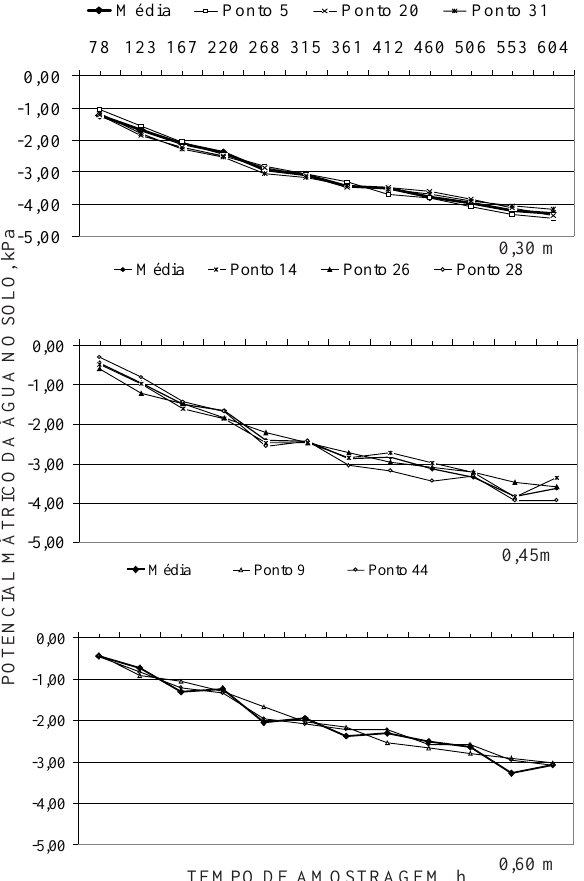
Figura 7. Comparação entre os potenciais mátricos médios da água no solo e os potenciais mátricos da água nas posições com estabilidade temporal, ao longo do